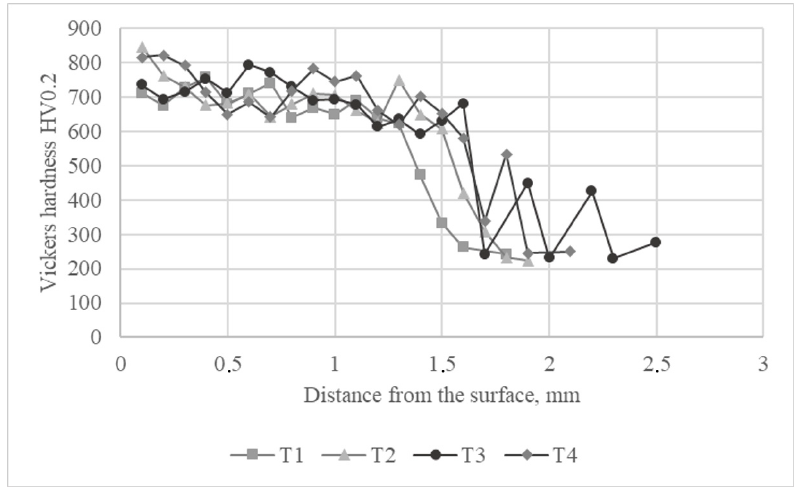
Figure 9. The laser alloyed surface layers hardness contribution (designation in accordance with Table 3).